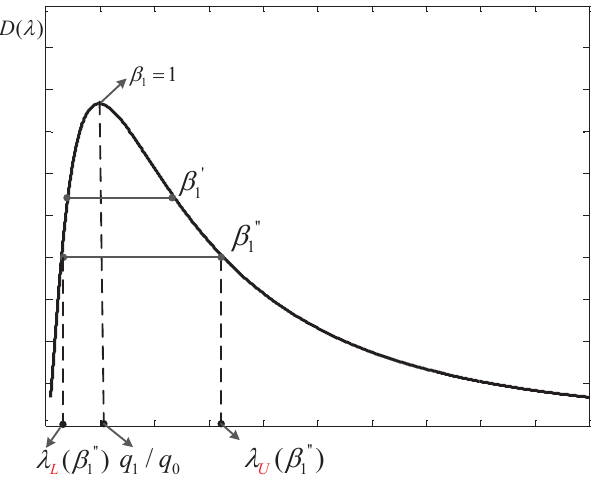
Figure 3. Diagram of the function D ( λ )